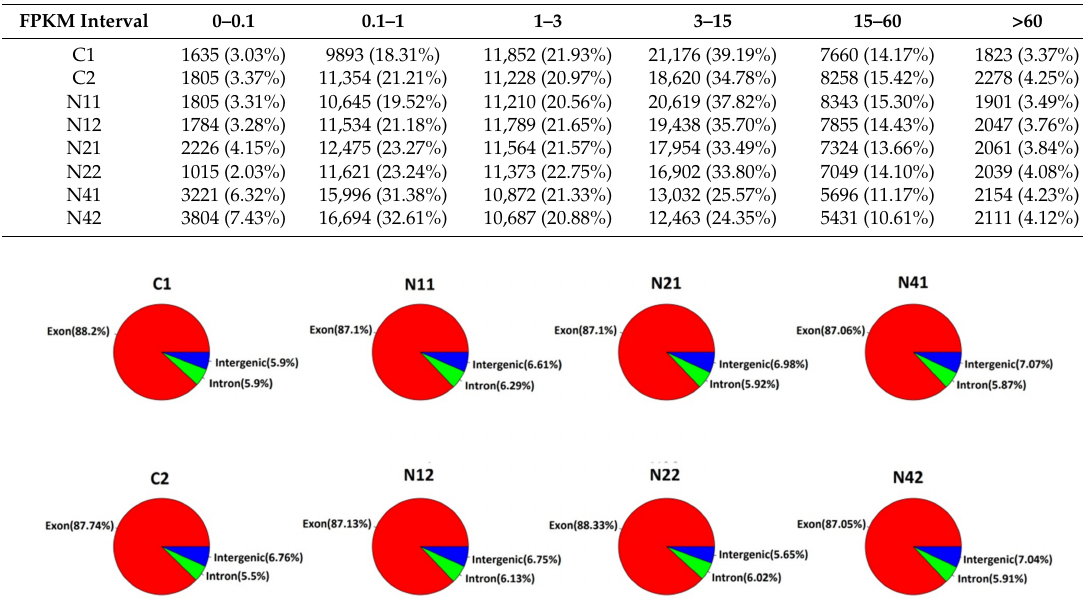
Table 2. The number of genes in different expression levels.